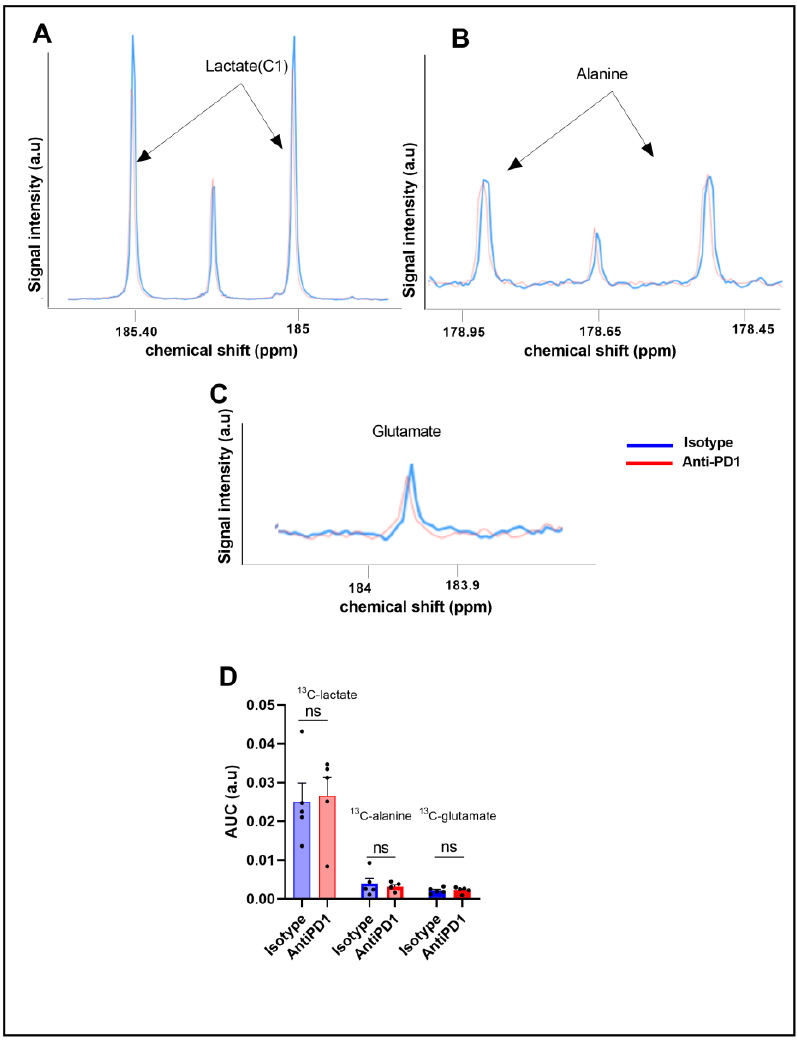
Figure 3. Ex vivo 13 C metabolic profiling after 13 C glucose feeding (fluxomic experiments) in response to the PD1 blockade. Representative spectra of lactate C1, alanine, and glutamate issued from the 13 C glucose metabolism in the control group (blue) and in the anti- PD1-treated group (red) ( A – C ). Quantification of the ex vivo 13 C-MRS detectable metabolites in YUMMER1.7 xenografts, represented by the area under the curve corrected for the internal standard (TSP) and tumor mass arbitrary units (a.u.) n = 5/grp ( D ). The dots correspond to the data points.